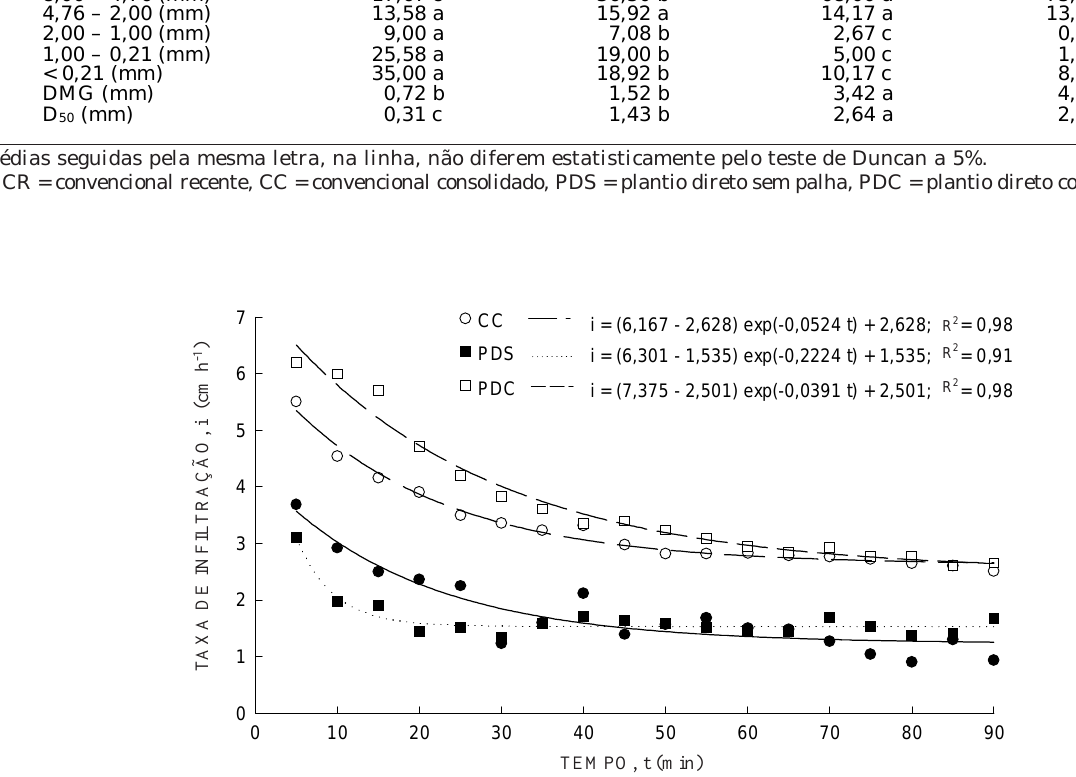
Figura 2. Taxa de infiltração da água (i) no solo em função do tempo (t) de aplicação da chuva, em diferentes preparos e consolidação do solo (CR = convencional recente, CC = convencional consolidado, PDS = plantio direto sem palha, PDC = plantio direto com palha). Equação de infiltração: i = (i i . *** = P < c